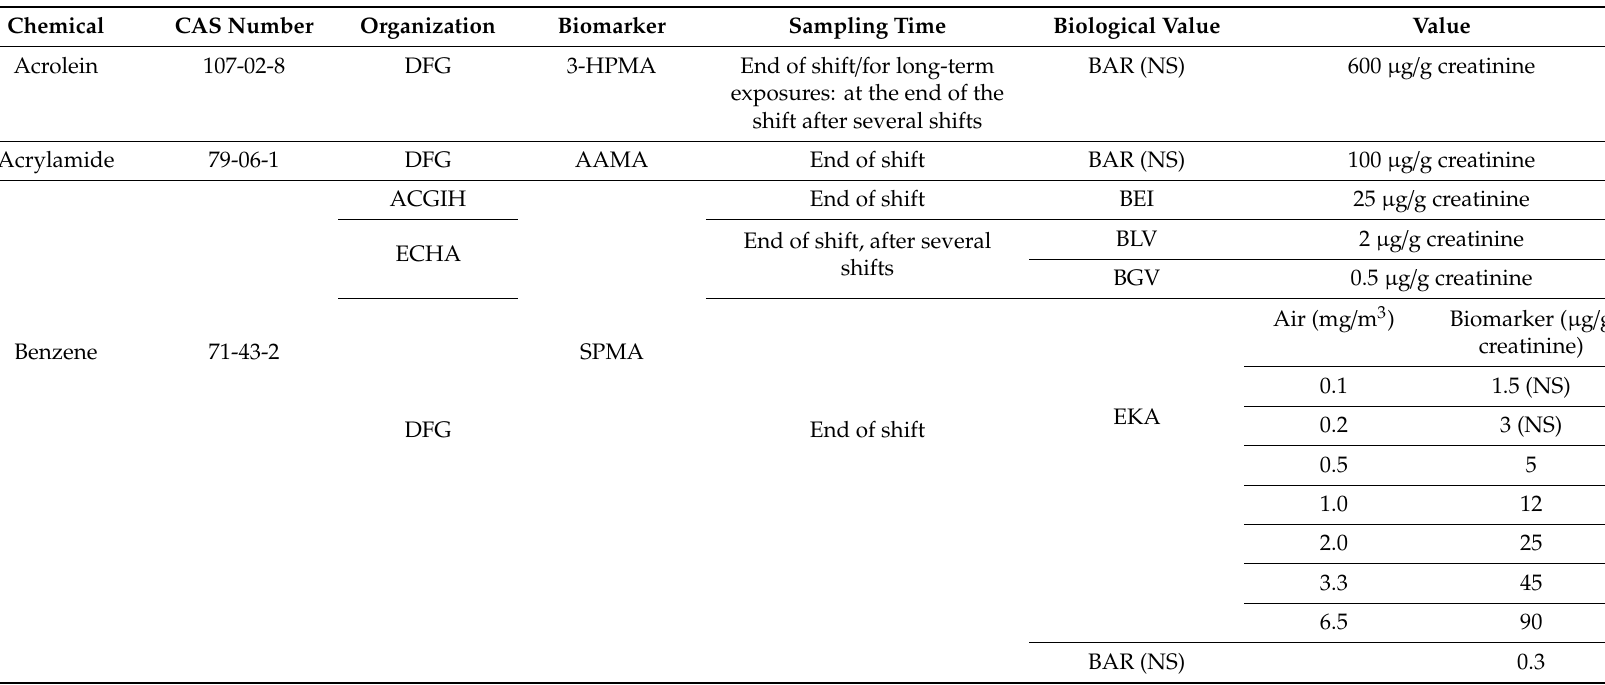
Table 1. Biological limit values for mercapturic acids of di ff erent volatile organic compounds recommended by the American Conference of Governmental